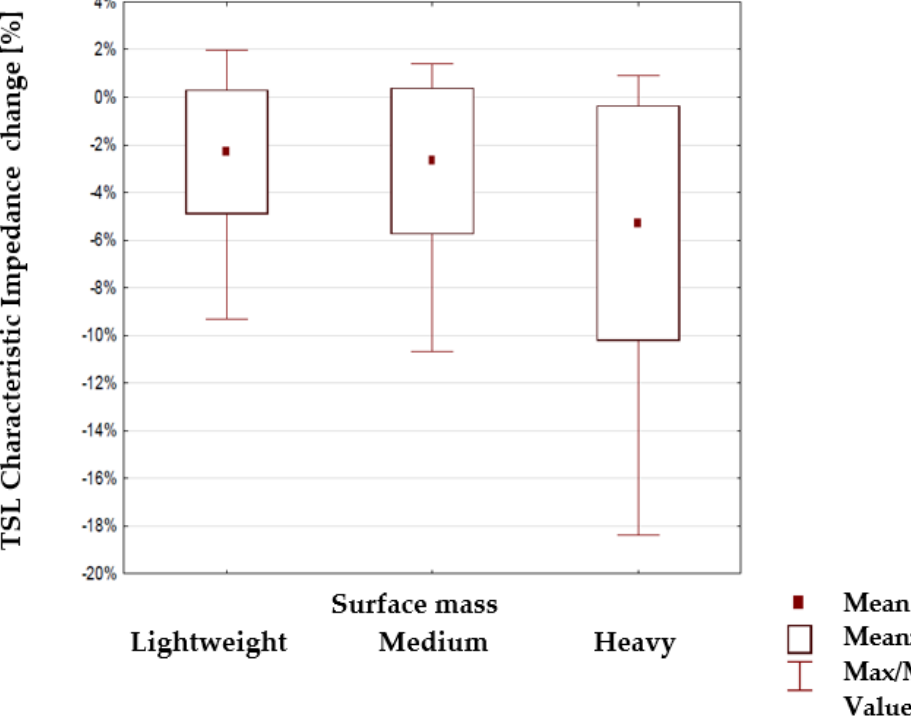
Figure 11. Changes in the line characteristic impedance under load for lines with a different surface mass of the substrate.